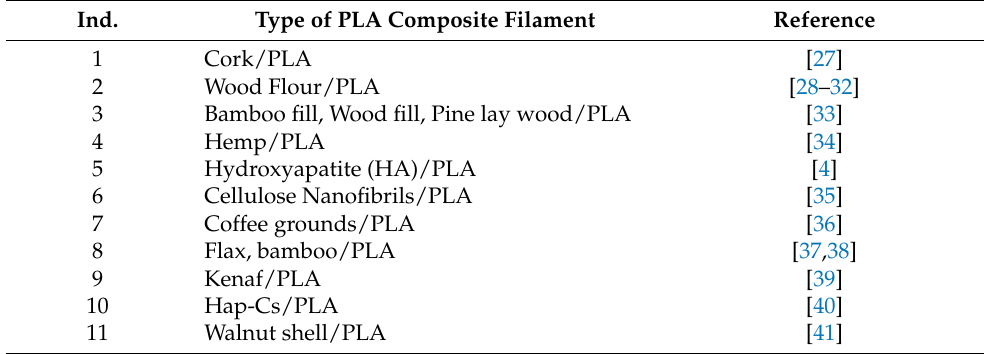
Table 1. PLA-based composite filament.